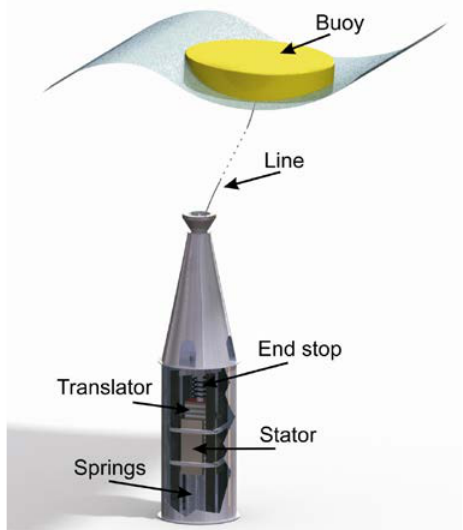
Fig. 1. Description of the WEC developed at Uppsala University [18].